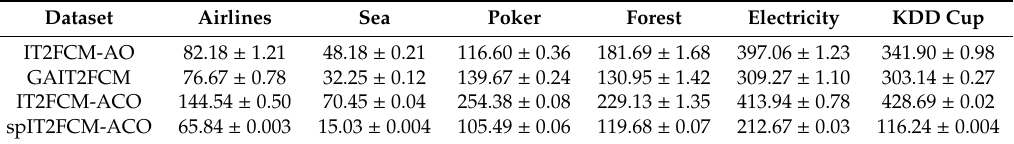
Table 7. Evaluation of Run Time